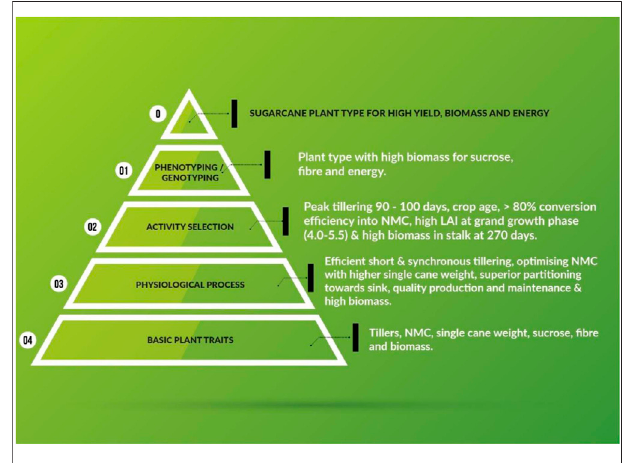
FIGURE 2 | Schematic illustrating primary plant traits of sugarcane that increase ef fi ciencies in physiological and economic